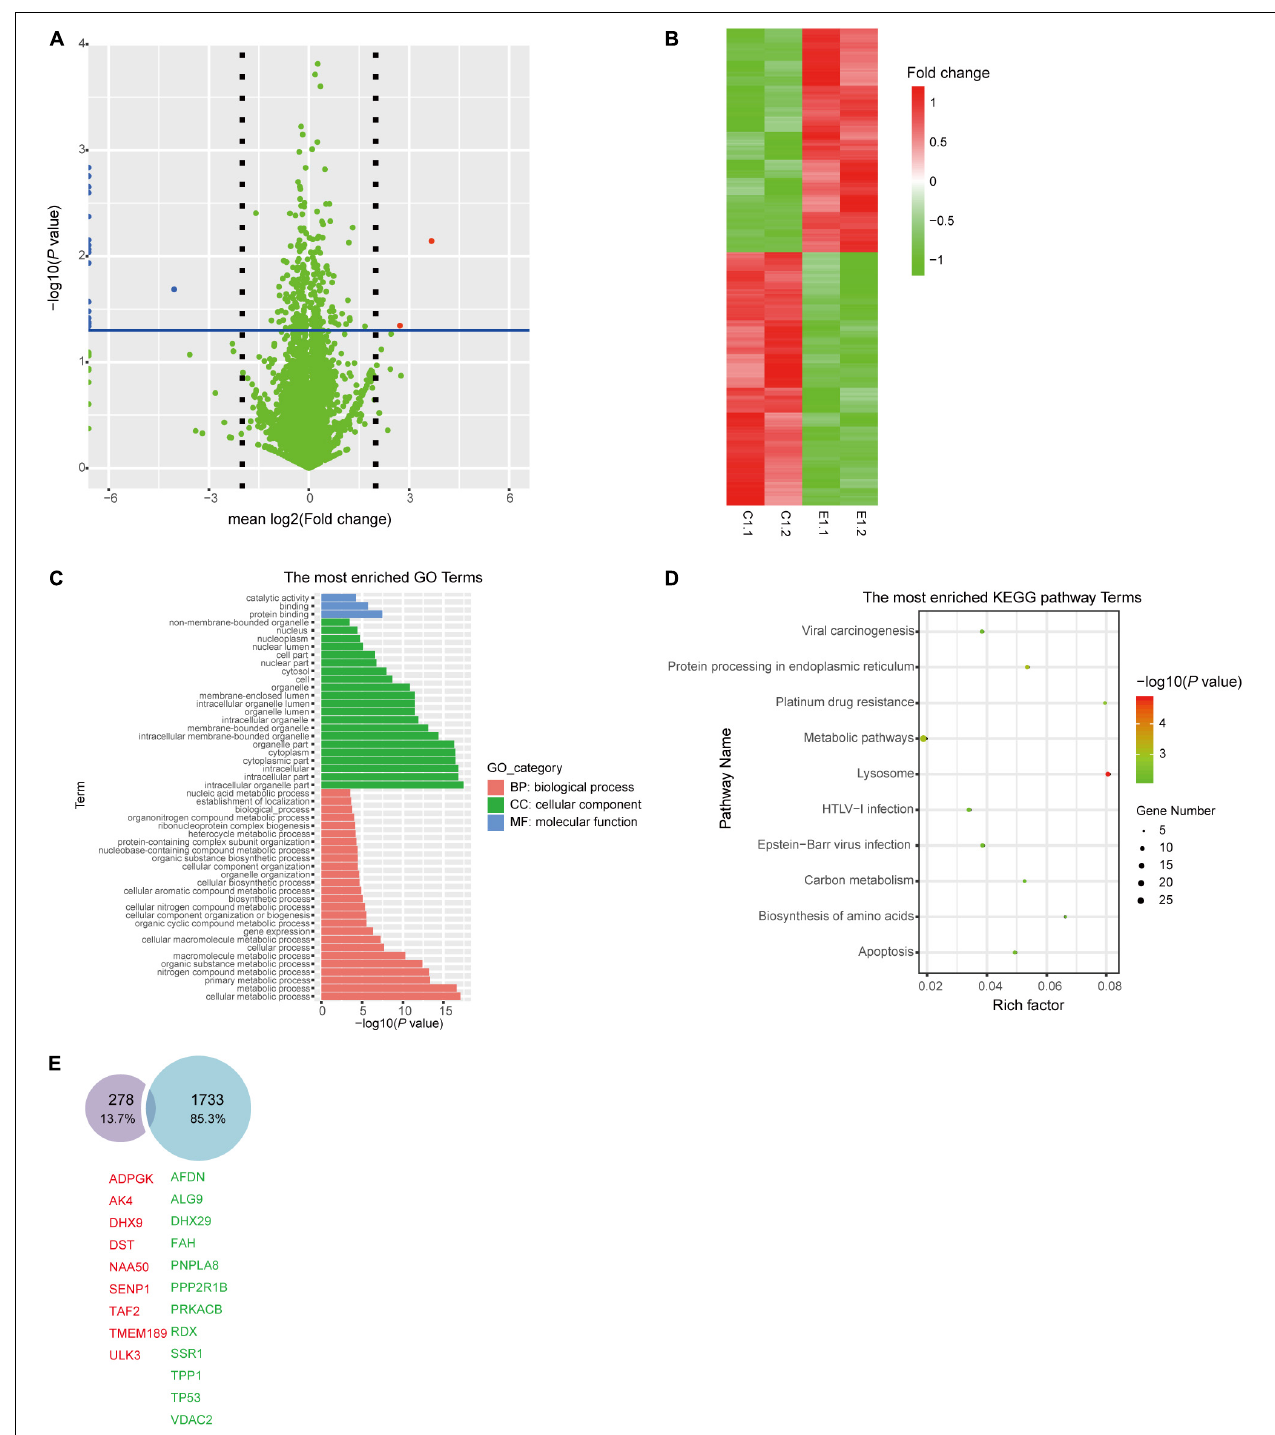
FIGURE 3 | The abundance of cellular proteins were altered by sRNA71. (A) Volcano plot of − log 10 P -values and mean log 2 Fold change for 6,600 proteins from HEK293T cells transfected with sRNA71 mimics compared to those transfected with negative control. Red dot, upregulated proteins; Blue dot, downregulated proteins. (B) Proteomics heat map represented 309 dysregulated proteins in HEK293T cells which were determined by Student’s t -test ( P < 0.05). All procedures in experimental groups (E1.1, E1.2, for short) were in accordance with control groups (C1.1, C1.2, for short). (C,D) GO annotation and KEGG pathway enrichment of 309 dysregulated proteins. The graphs were made with R package “ggplot2” (version 3.6.1). (E) Venn diagram depicts the number of the intersection between sRNA71 candidate target genes (blue circle) and genes corresponding to differentially expressed proteins (purple circle), including nine upregulated genes (red tag) and 12 downregulated genes (green